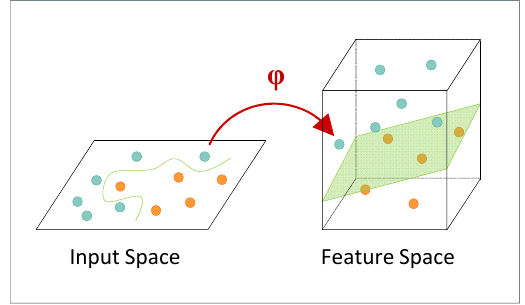
Figure 5. Scheme of SVM principle.